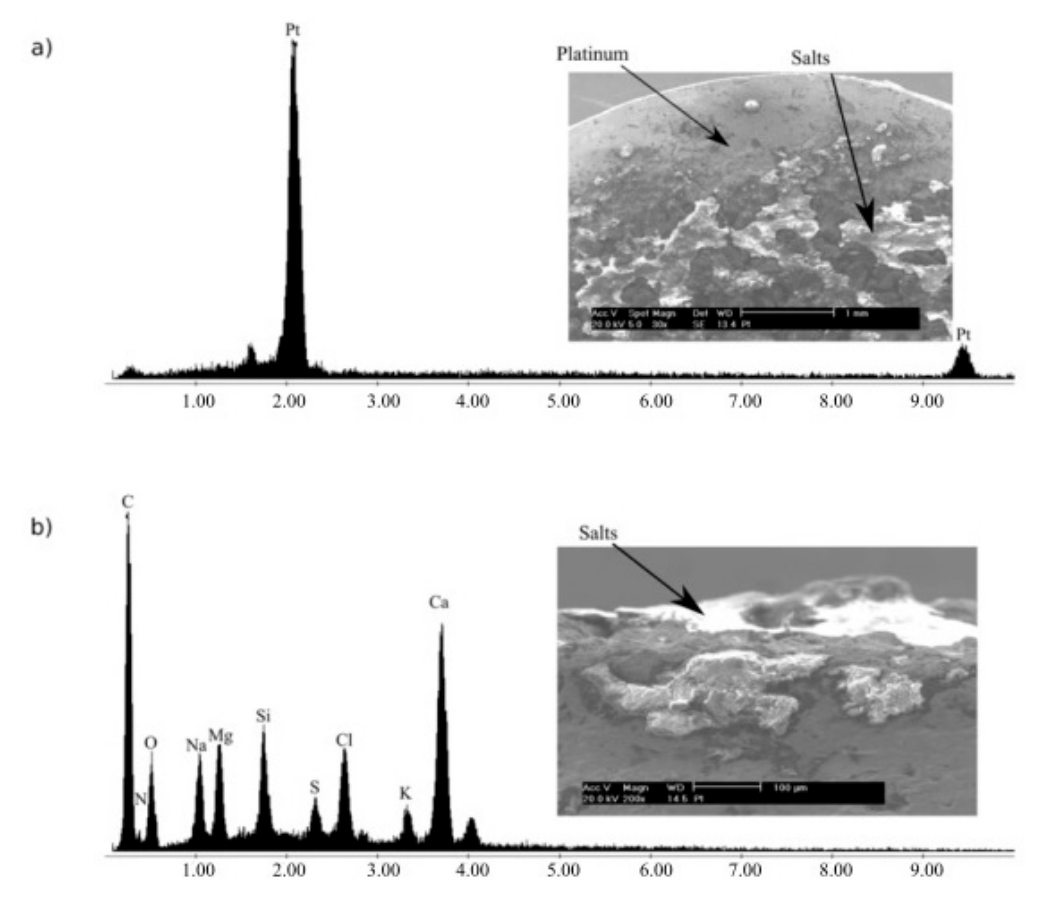
Figure 6. Photomicrographs and chemical analysis of a sample surface after testing. ( a ) EDS for the platinum (gray area) and ( b ) magnification of salt layer showing surface roughness and its EDS analysis.